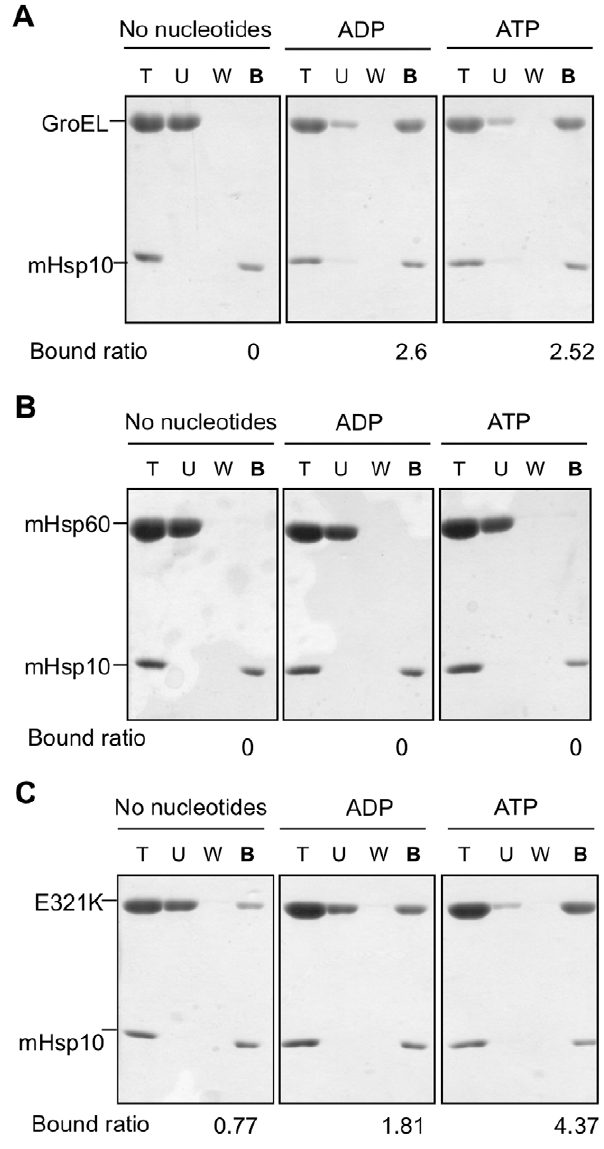
Figure 4. A stable complex is formed between the E321K mutant and mHsp10. Interaction between mHsp10 and different chaperonins was measured using a pulldown assay. 50 m M of His- tagged mHsp10 together with 50 m M of GroEL (A), mHsp60 (B), or E321K mutant (C) were incubated with nickel beads in the absence of nucleotides, or in the presence of 4 mM ATP or 4 mM ADP. Equivalent aliquots of 2 m l from the total sample (T), unbound fraction (U), fourth wash (W), and bound fraction (B) were analyzed by SDS-PAGE and stained with Coomassie blue. The intensities of the bands were quantified by densitometry (ImageMaster 1D Prime program). The bound ratio listed on the bottom of each gel represents the ratio between the intensities of the chaperonin and co-chaperonin bands in the bound fraction.